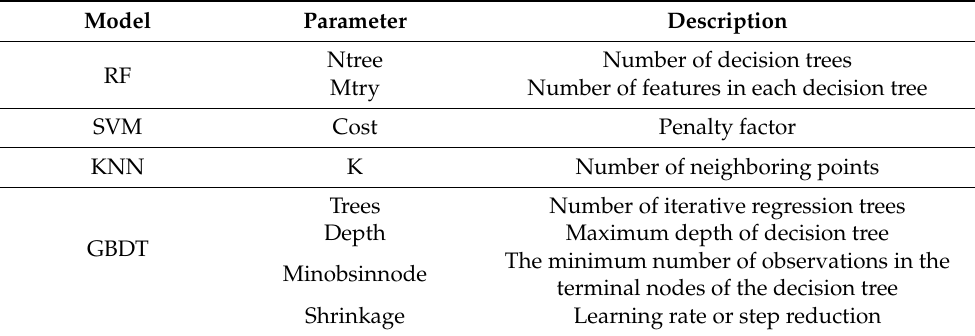
Table 2. Parameters and descriptions in machine learning